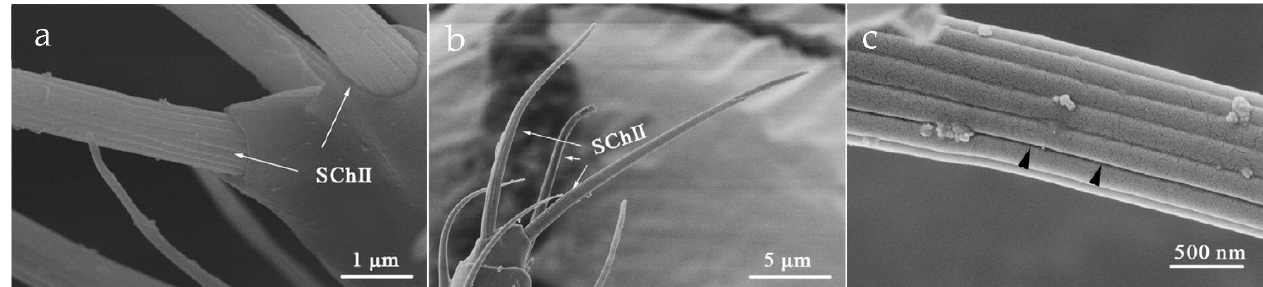
Figure 9. Sensilla chaetica II (SChII) on the flagellum VI. ( a ) O. loti . ( b ) S. kaszabi . ( c ) M. distalis . There is a longitudinal opening at the SChII indicated by the black arrow.